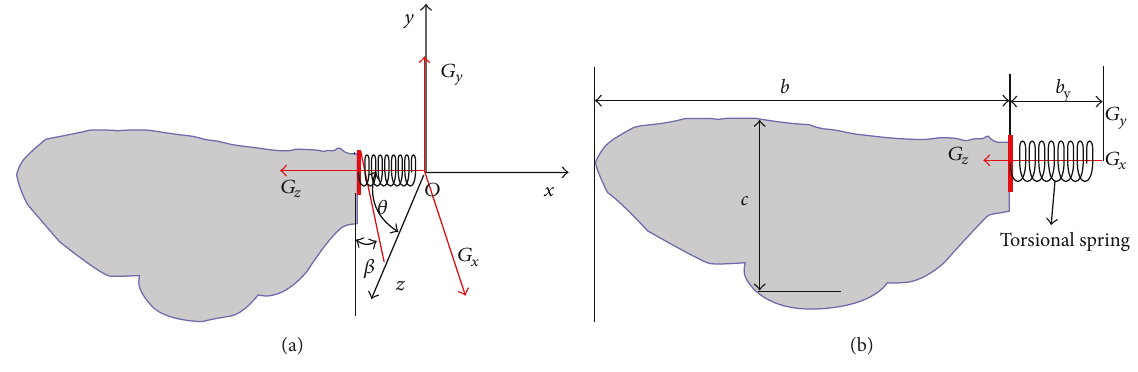
Figure 1: The schematic of the wing